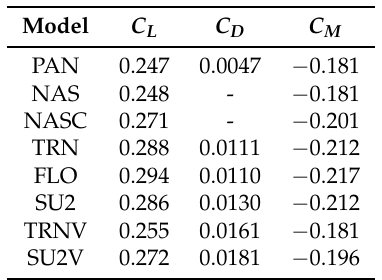
Table 4. Aerodynamic coefficients obtained by different levels of fidelity for the Onera M6 wing at Mach 0.839 and angle of attack 3.06 ◦